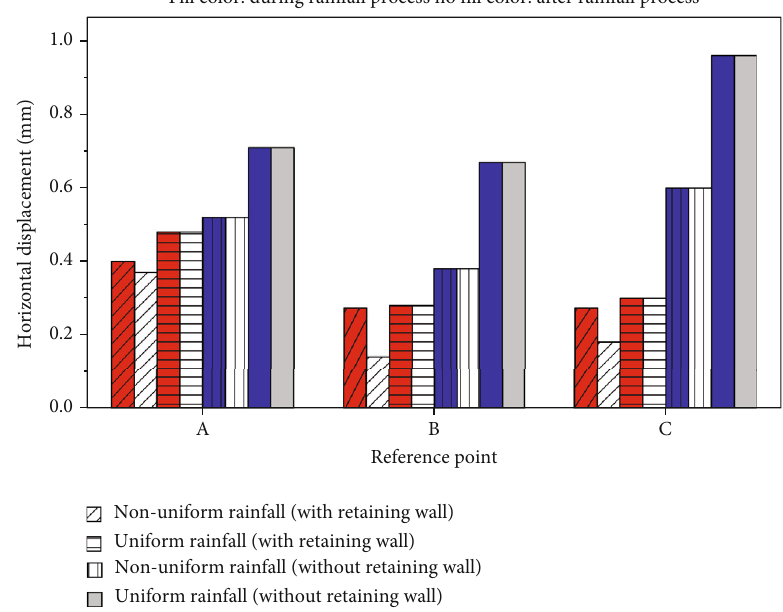
Figure 11: The horizontal displacement of the slope reference points with retaining wall under